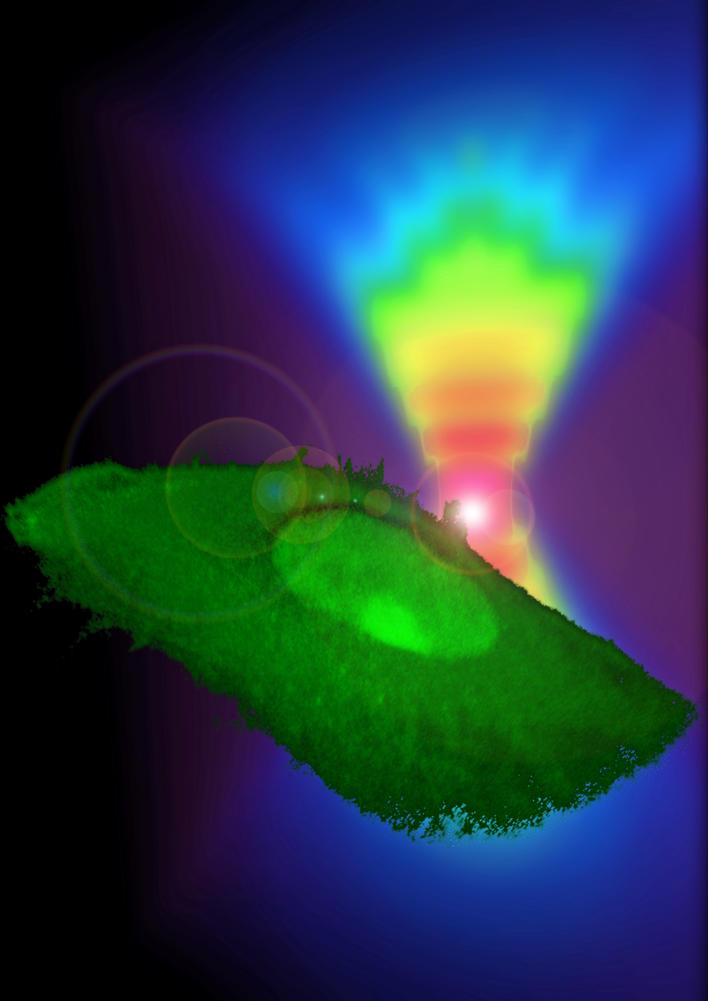
Fluorescence accumulation in the nucleus indicates TTDA retention during the repair reaction at a locally ultraviolet-irradiated area in a living human fibroblast in this three-dimensional reconstruction. (Image: Pierre Olivier Mari and Giuseppina Giglia-Mari)